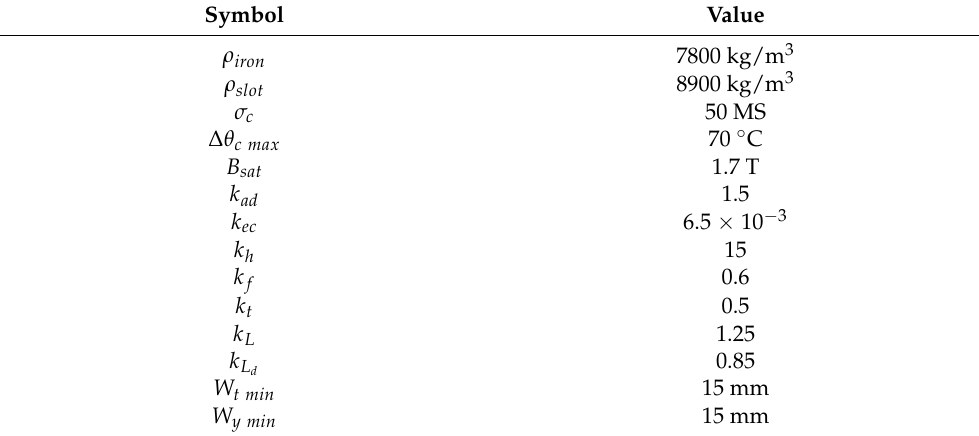
Table 3. Constant data.